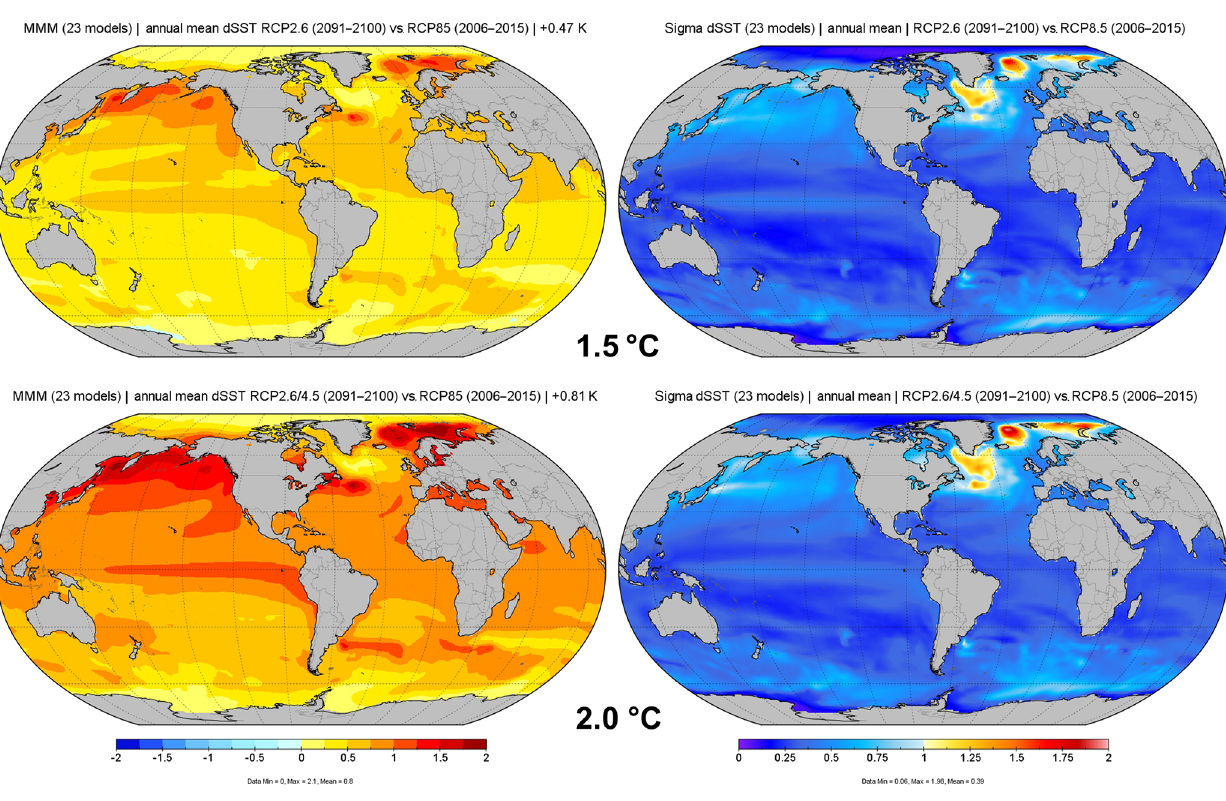
Figure 3. Left: SST warming pattern added to the current decade to produce the (top) 1.5 ◦ and (bottom) 2 ◦ scenarios. Right: the standard deviation of annual mean delta SSTs across the 23 models. Units are in ◦